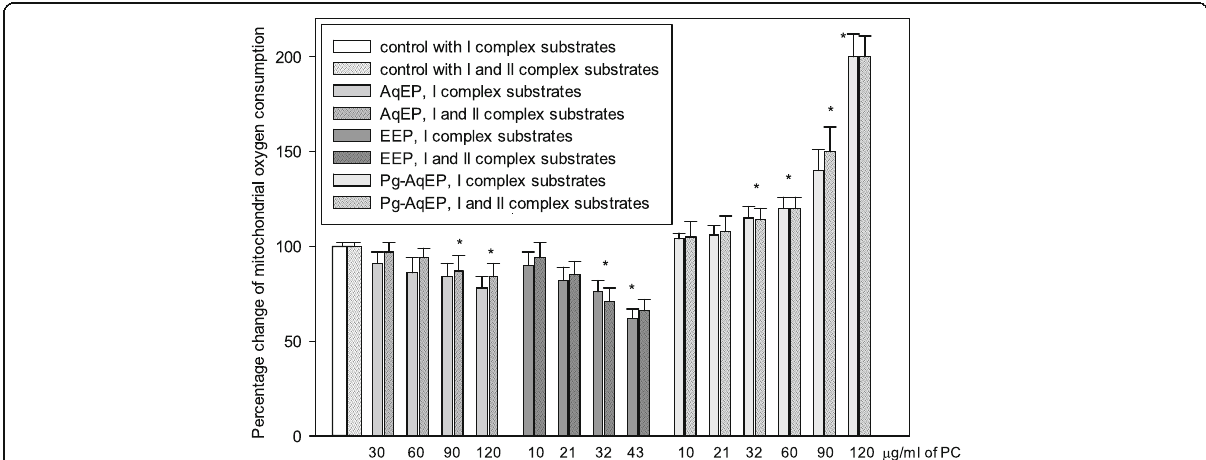
Fig. 5 Effect of propolis extracts on mitochondrial non-phosphorylating respiration rate in C6 cells. Incubation of cells and measurement of the digitonin-permeabilised cell mitochondrial respiration were performed as described in Materials and Methods. The respiration rates are expressed as pmol O 2 /(s*2 × 10 6 cells). Data are presented as means of percentage of control cells ± SE (n = 5). * p < 0.05 versus